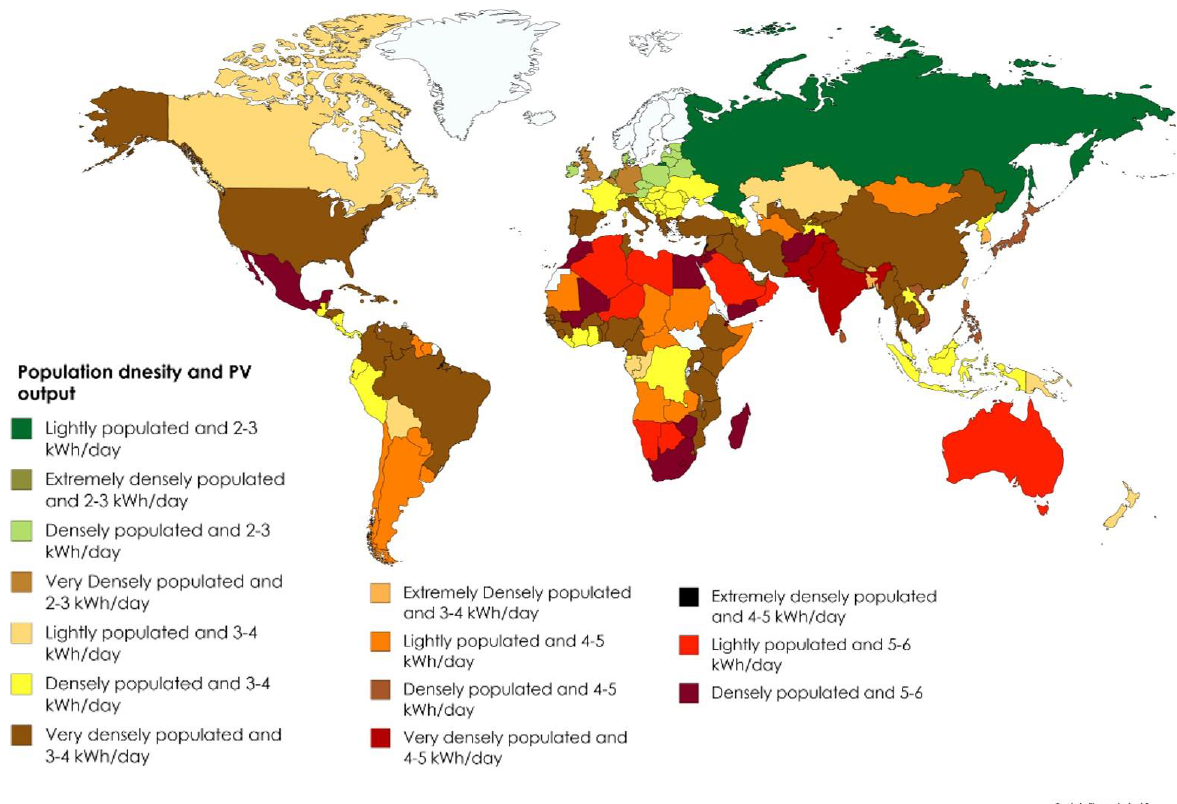
Figure 2. PV output combined with population density. The colors represent the data as indicated in the legend.